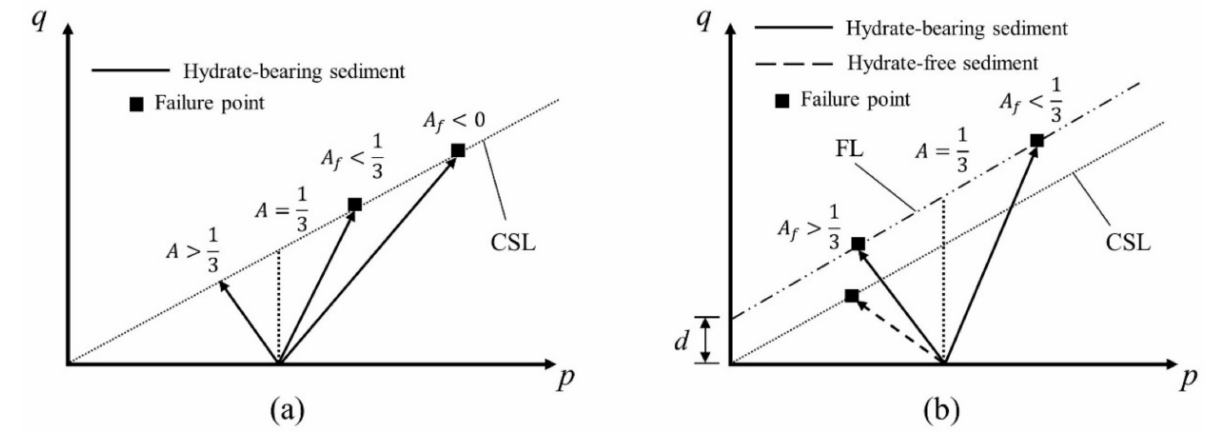
Figure 9. Typical characteristics of pore pressure coefficient A response of different sediments in q − p (cid:48) plane. ( a ) sand sediments, ( b ) clayey-silt sediments.